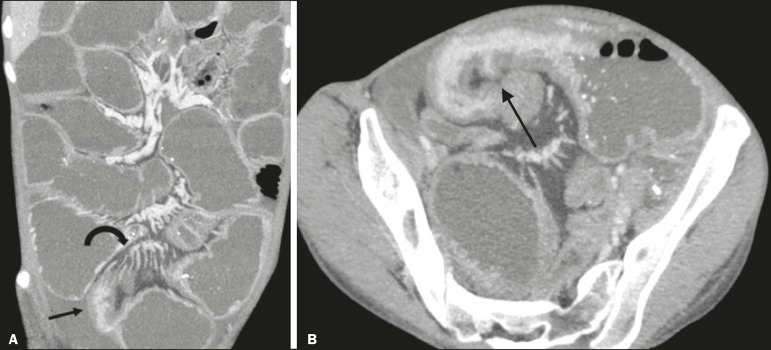
A: CTE image with coronal reconstruction, after intravenous and oral contrast, showing stenotic wall thickening with mucosal hyperenhancement (straight arrow) in the distal ileum, resulting in obstruction with consequent diffuse dilatation of upstream loops. There is also engorgement of the mesenteric vessels, known as the “comb sign” (curved arrow). B: Axial image of the same patient, showing a long stretch of stenotic thickening in the distal ileum (arrow).